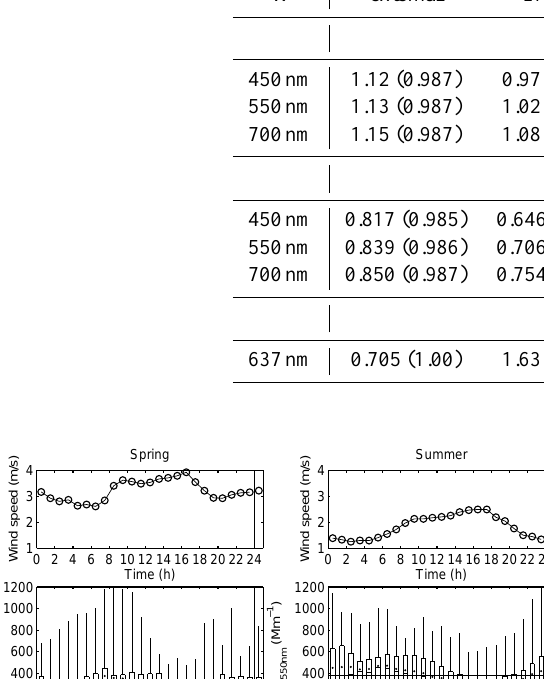
Table 2. The fitting parameters (b) and correlation coefficients (R) of the linear fittings for calculated and measured σ sp , σ bsp and σ ap . spring summer λ external internal external